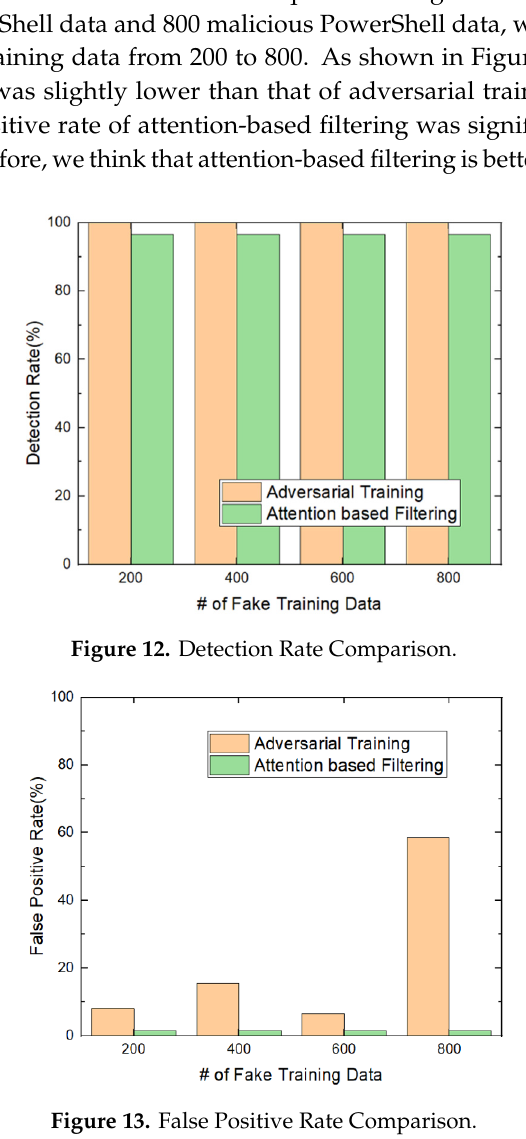
Figure 13. False Positive Rate Comparison.